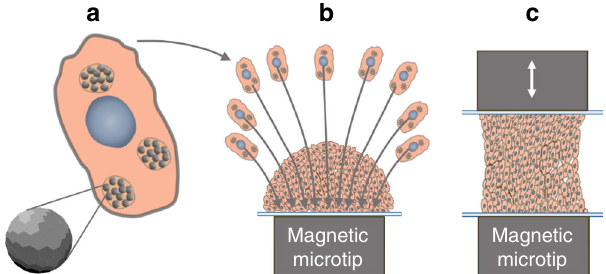
Fig. 1 Schematic illustrating the different steps involved in the magnetic stretcher. a Nanoparticles incorporation in ESCs, b EBs formation from magnetized ESCs driven by a magnetic microtip, and c EBs magnetic stimulation in situ, in the 3D geometry, and without the need for a supporting